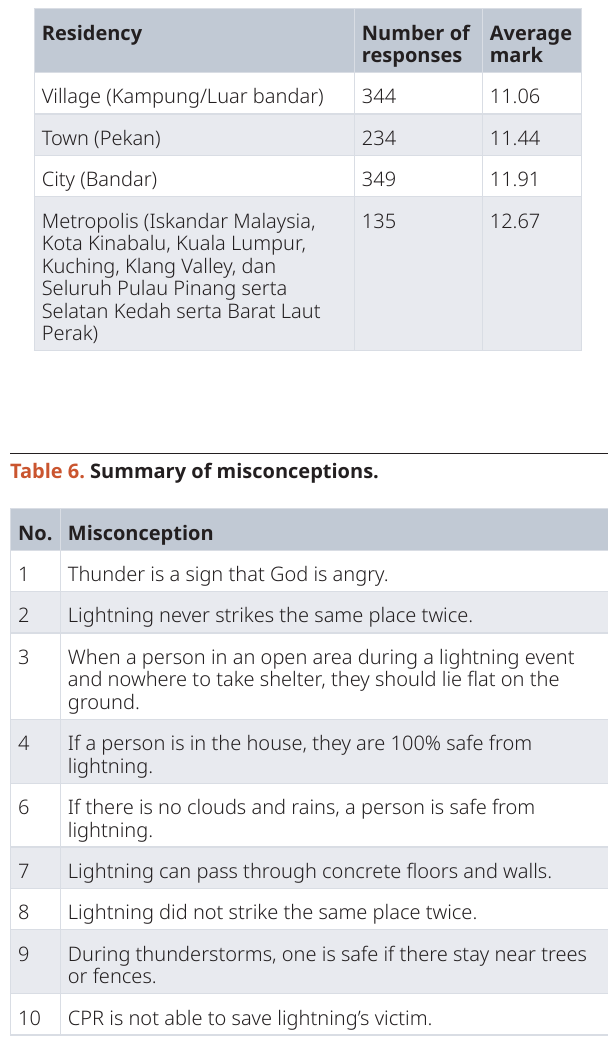
Table 5. Responses according to